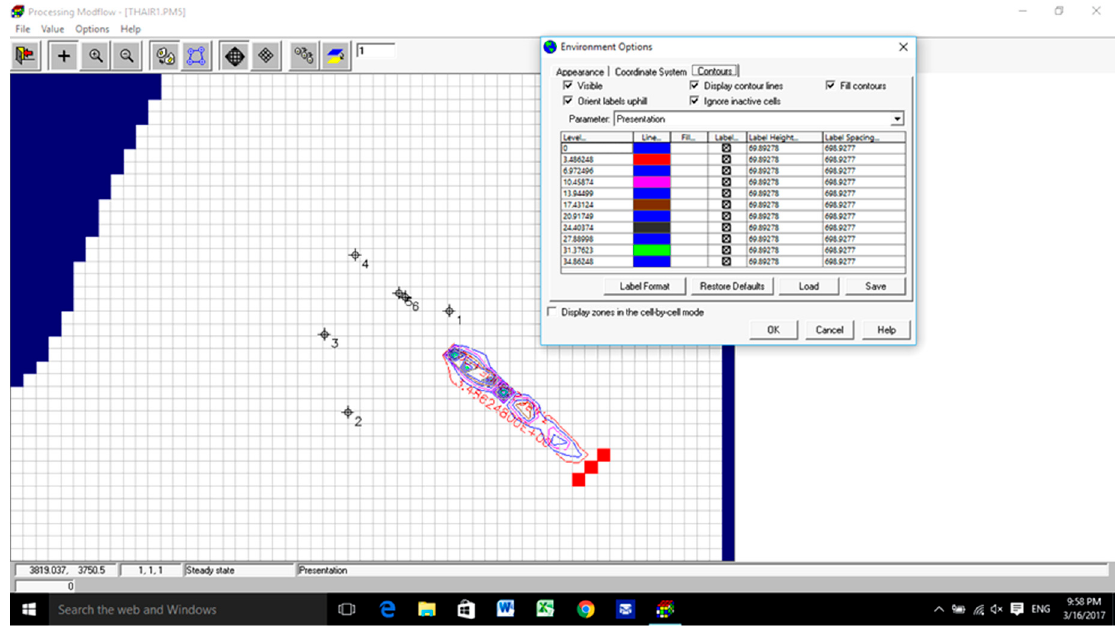
Figure 13. The extent of Co-60 pollutant concentrations from the LAMA area after 10 years for Scenario 1.